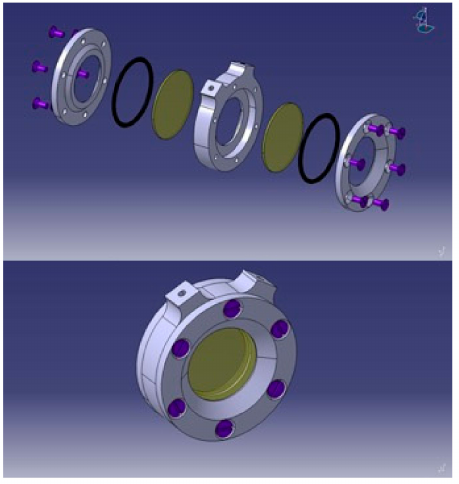
Figure 2. Technical drawing of the new sample cuvette equipped with ZnSe windows, which is used for the simultaneous FTIR and SANS investigation of samples using the KWS-2. The liquid samples can be filled in by using the top openings, while the black O-rings, the series of screws (violet), and Teflon screws for the top openings provide the cuvette tightness. Cuvettes with 1 mm and 2 mm sample thickness are provided; the sample thickness can be further decreased to 0.5 mm or 0.2 mm by using additional ZnSe windows of appropriate thickness and diameter that can be placed inside of the cuvette, between the yellow windows shown here.